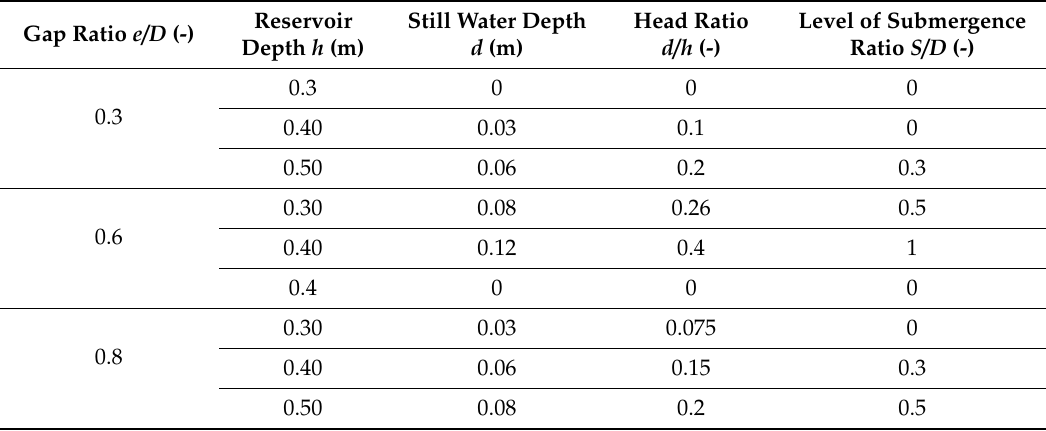
Table 2. List of experimental configurations in the presence of a